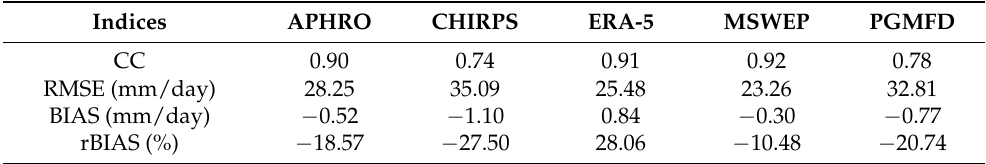
Table 3. The statistical metrics for monthly performance evaluation of GPPs in contrast to in-situ gauges data during the entire study period